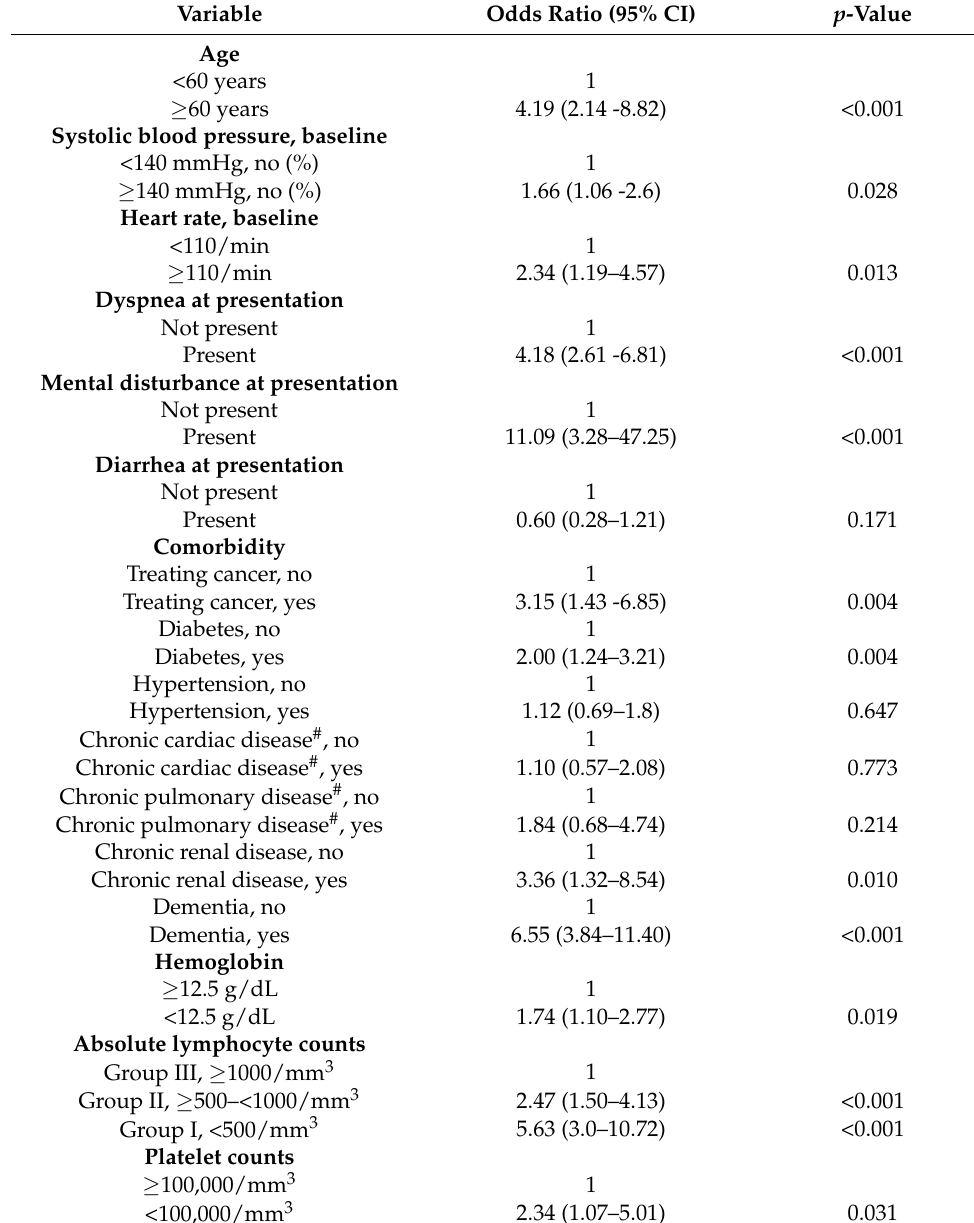
Table 4. Multivariate analysis of factors associated with the event of